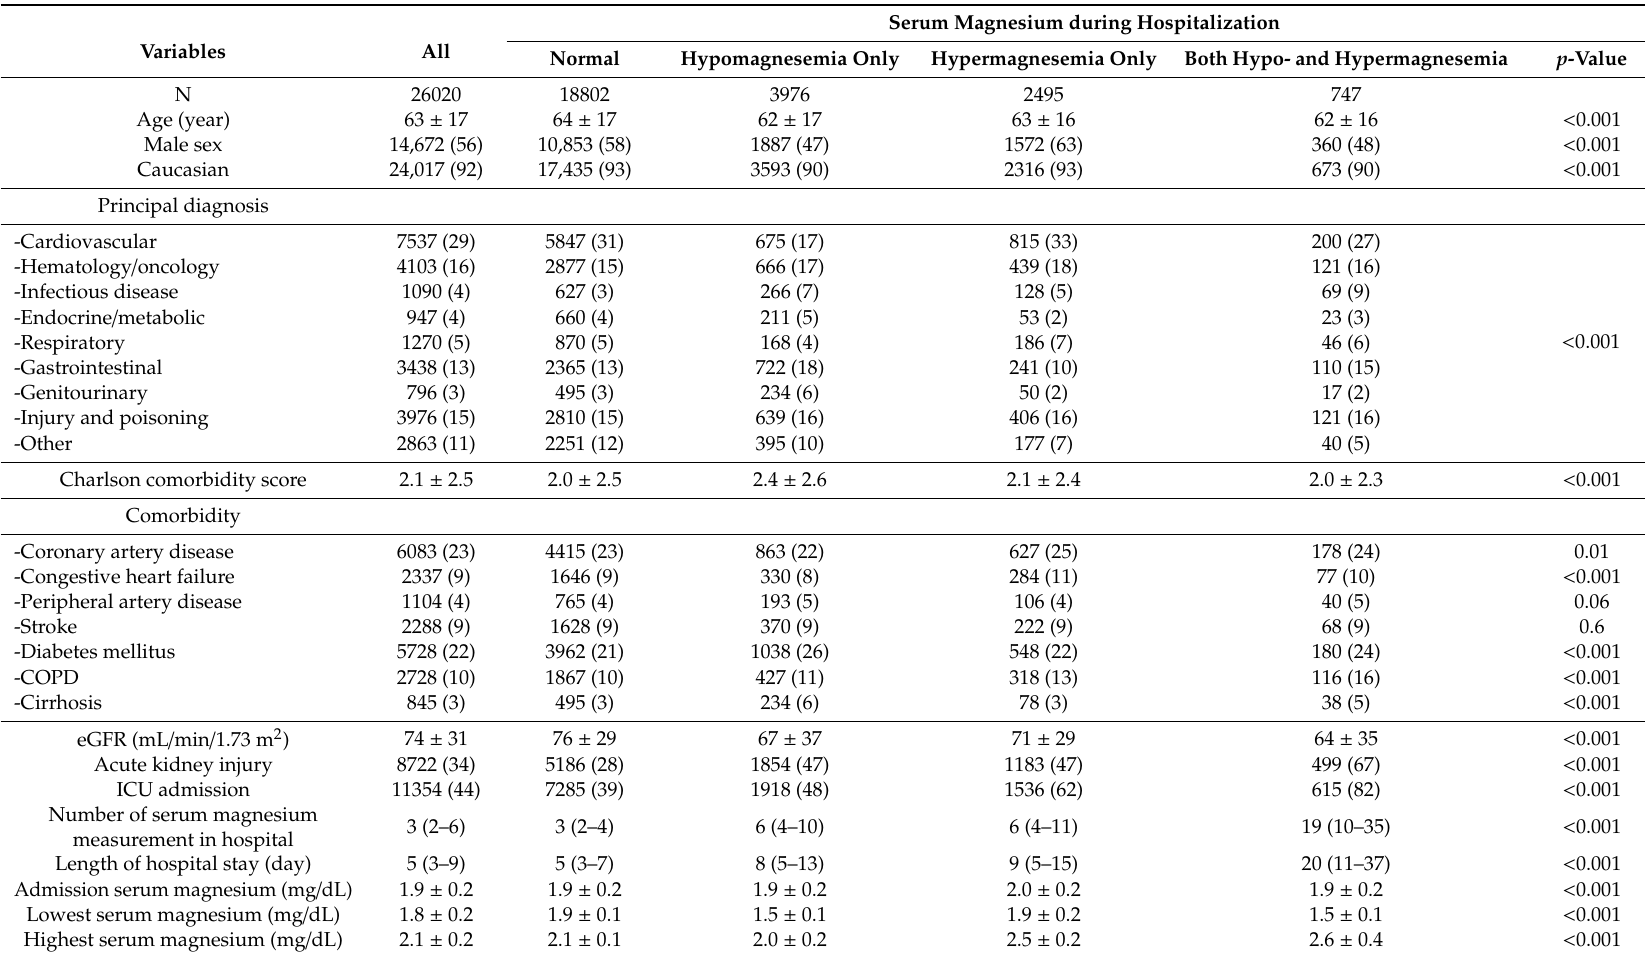
Table 1. Clinical characteristics of study